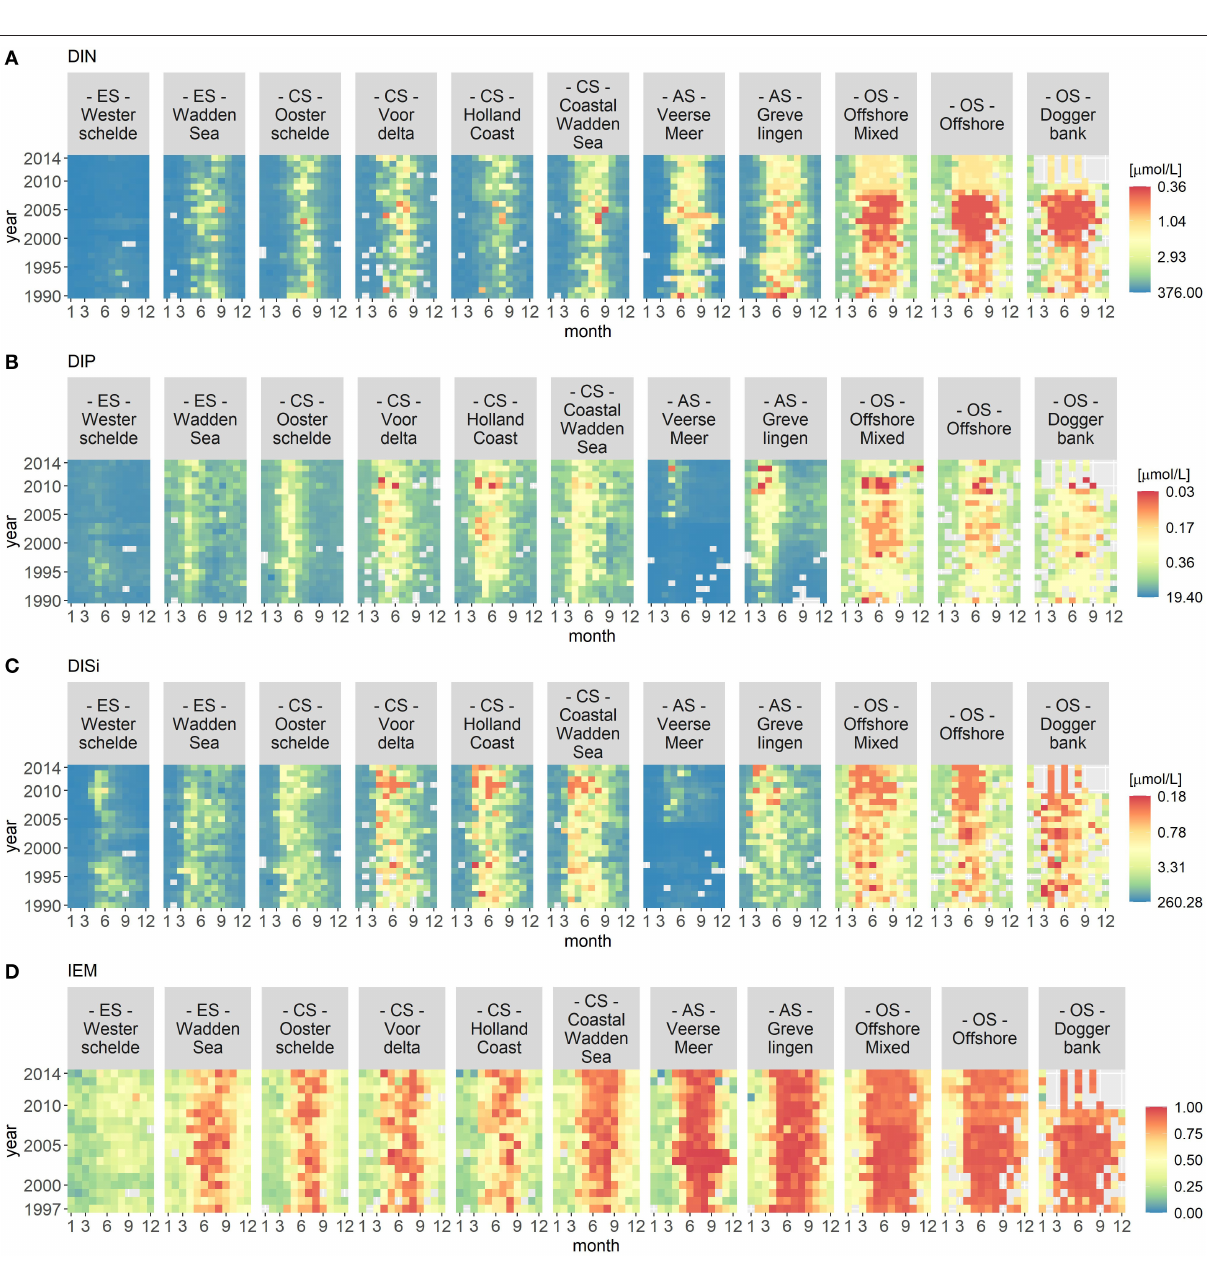
these abiotic parameters, the location classes can be grouped into four